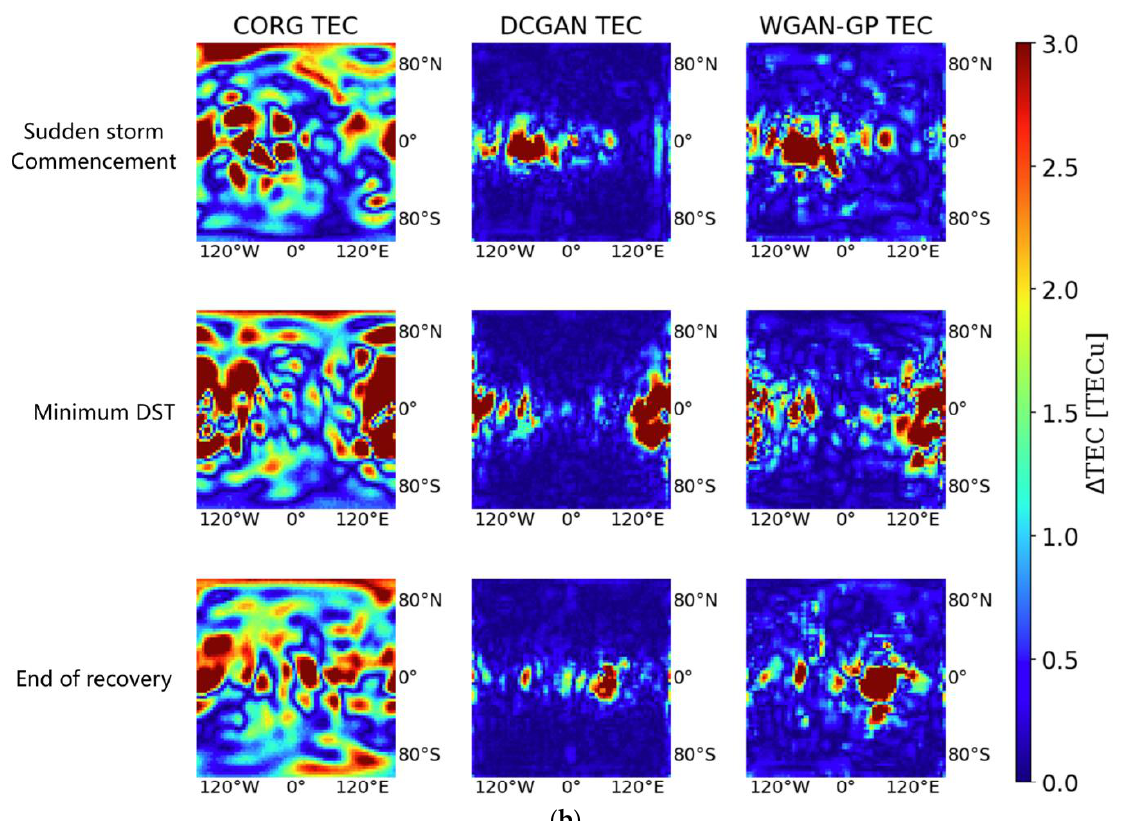
Figure 9. The ionospheric TEC ( a ) and the ionospheric TEC difference ( b ) for the geomagnetic storm on 7 September 2017. The sudden storm commencement, minimum DST , and end of recovery indicate three time points for the geomagnetic storm, as described above. Table 5. RMSE and MAE performance during geomagnetic storm in September 2017.